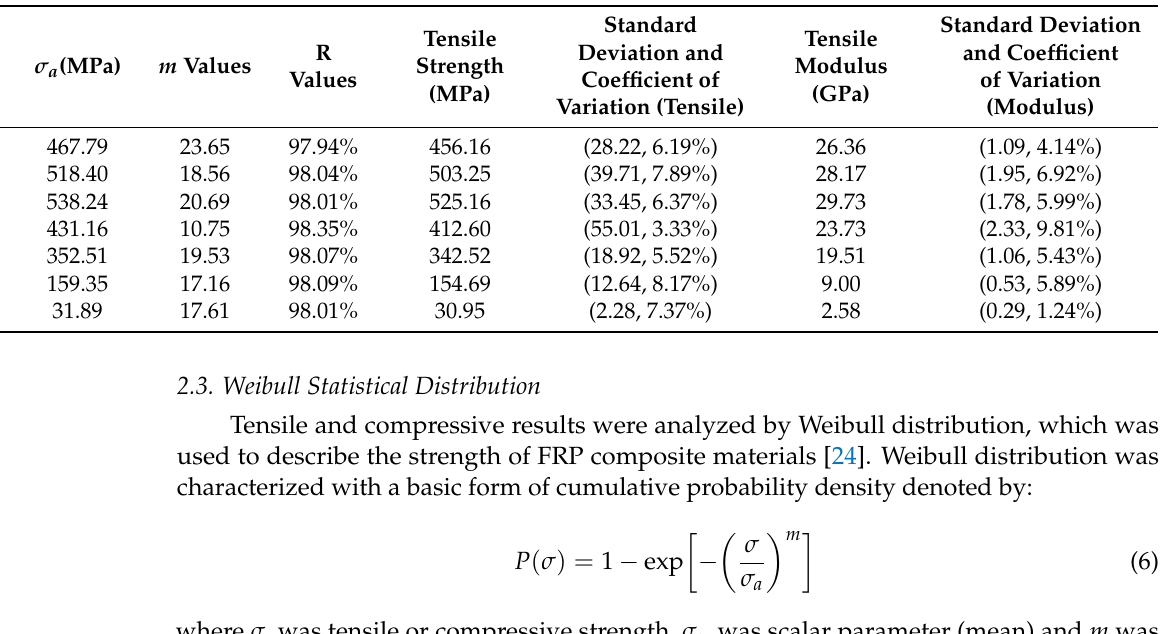
Table 3. Tensile strength and modulus of laminates at various testing